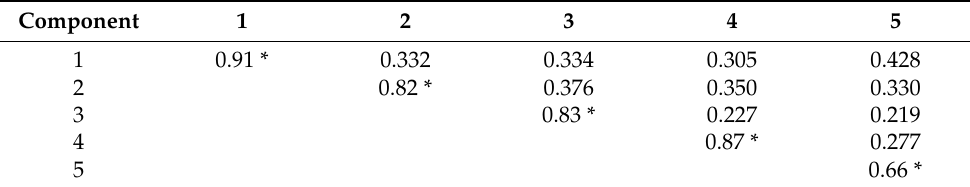
Table 6. Factor intercorrelations—committing cyber-violence